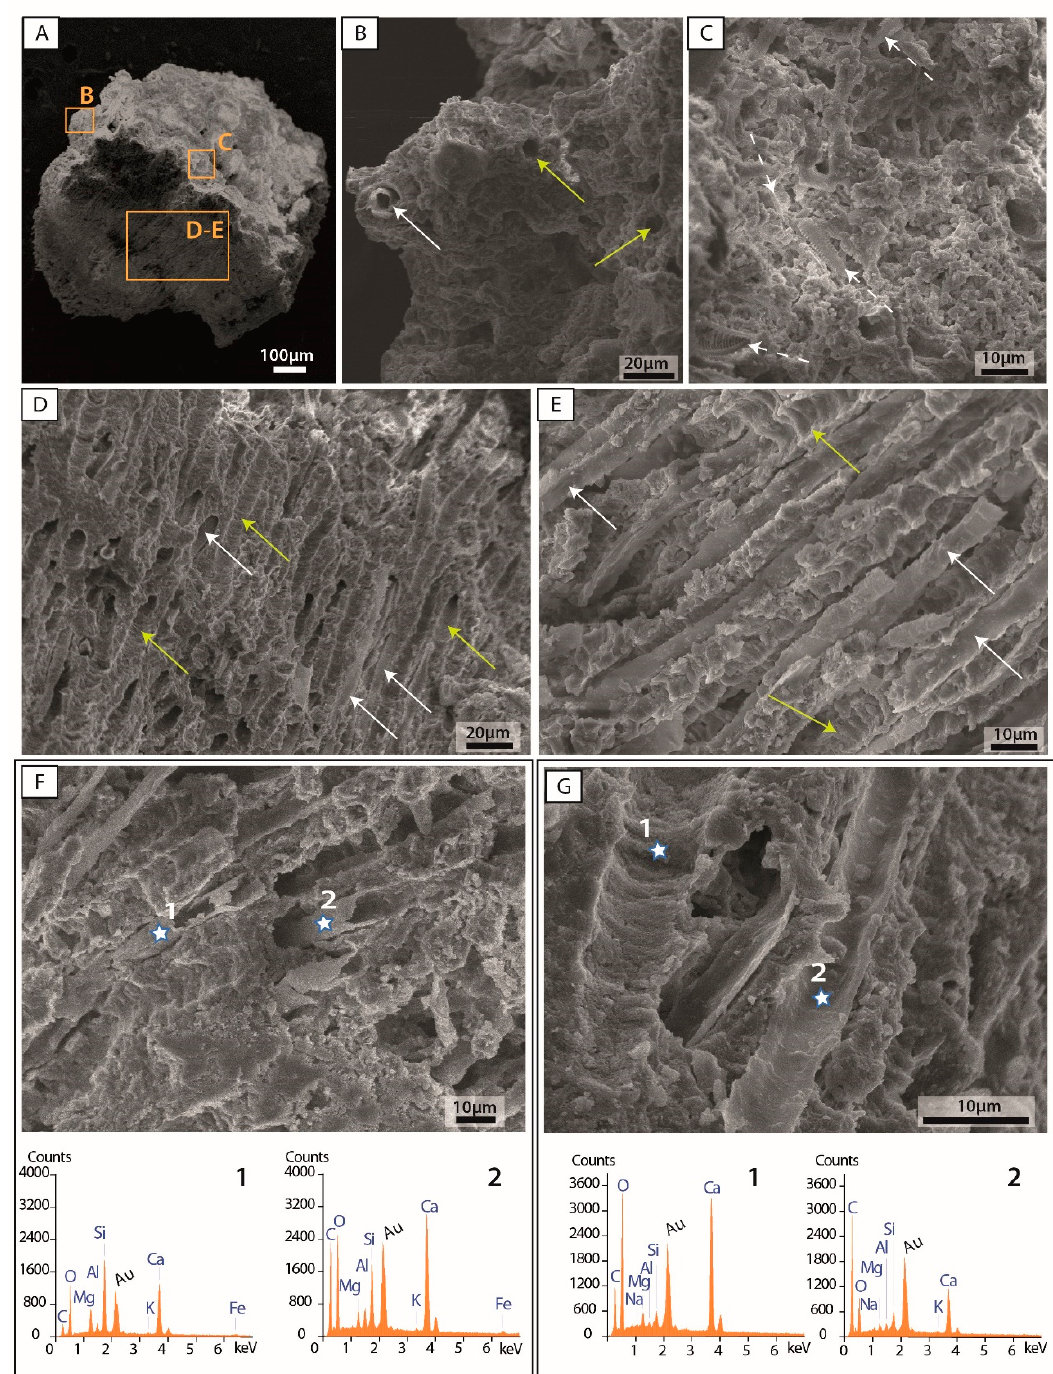
Figure 5. SEM photomicrographs and energy-dispersive microscopy (EDS) analyses of pieces of dried crusts. ( A ) Piece of crust. Rectangles highlight areas shown in the following SEM photomicrographs. ( B ) At higher magnification, rectangle B shows rounded pores (yellow arrows) and a rounded pore with a preserved filament sheath (white arrow). ( C ) At higher magnification, rectangle C reveals the presence of diatoms (dashed white arrows). ( D ) Under higher magnification of rectangle D,E, filament remains are indicated by white arrows, whereas yellow arrows point to filaments molds. ( E ) Under higher magnification of rectangle D,E, organic filaments are indicated by white arrows, whereas yellow arrows point to mineralization. ( F ) SEM photomicrograph of rectangle D,E showing the position of two EDS analytical measurements on the mineralized filament-like structures. ( G ) Rectangle D,E showing the position of associated EDS analytical measurements on the filament molds (1) and organic matter (OM) filament remains (2).